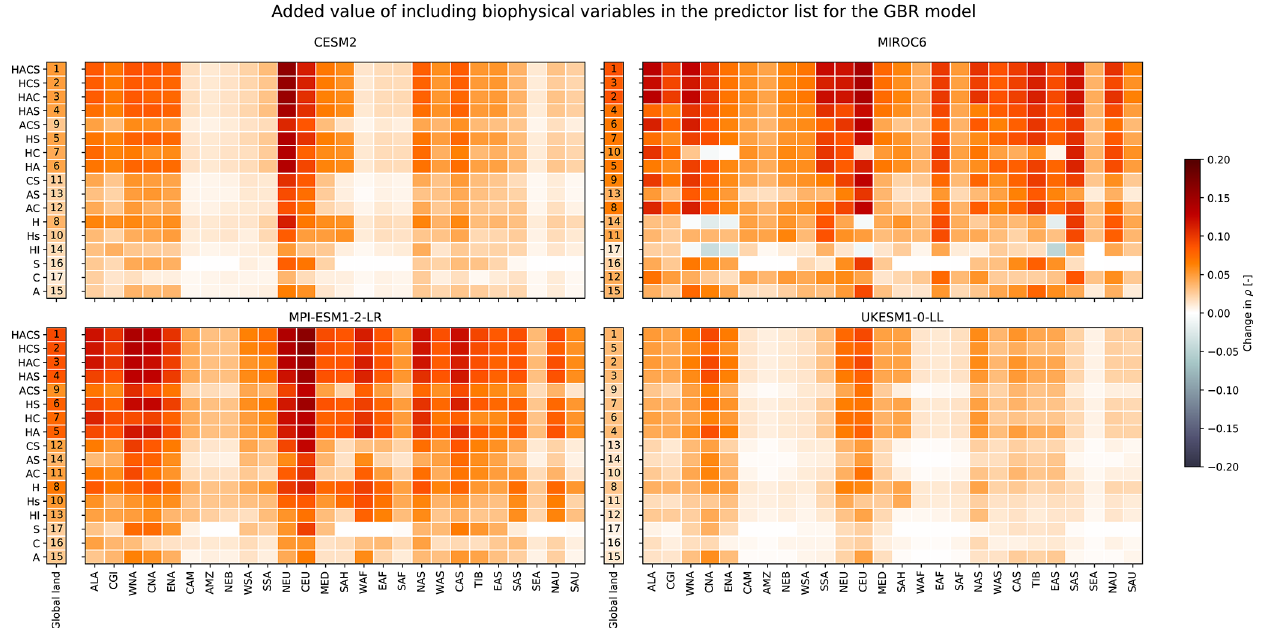
Figure 12. Global land (without Antarctica) and regional performances (columns) of the physically informed model trained using different predictor sets (rows) shown for four selected CMIP6 models, for each SREX region. Acronyms for the predictor sets ( y axis tick labels) can be referred back to in Table 1. Pearson correlations calculated over all months between test runs and harmonic-model test results augmented by the physically informed model’s predictions of residual variability are considered. Here we show changes in correlations relative to those obtained when augmenting using only T yr and month values as predictors. Numbers in the global land column indicate the ranking of each predictor set, where 1 is the